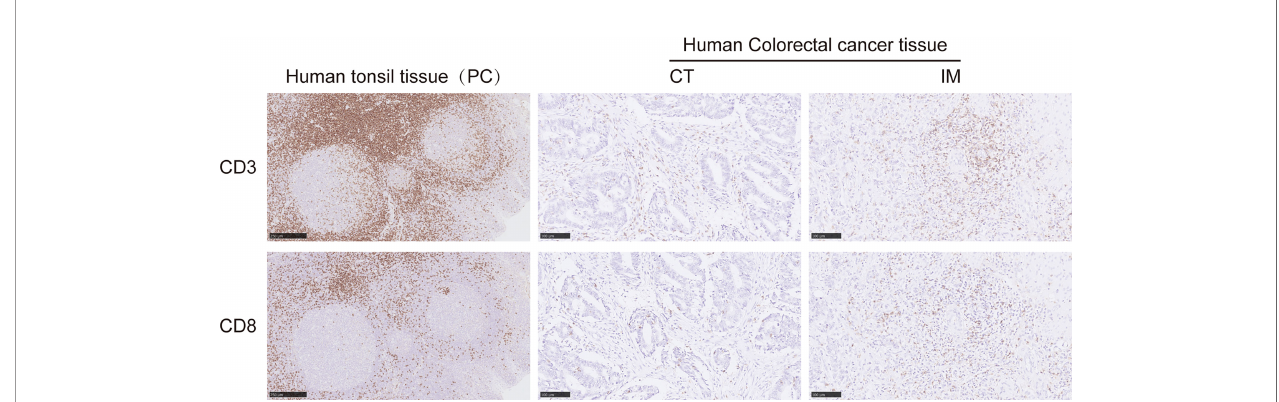
FIGURE 1 | Representative immunohistochemical images of CD3 + and CD8 + T cells on formalin- fi xed paraf fi n-embedded sections from human colorectal cancer (CRC) tissue. Representative images of CD3 + T cells in the CT ( middle upper panel ) and IM ( right upper panel ) and CD8 + T cells in the CT ( middle lower panel ) and IM ( right lower panel ). Human tonsil tissues were stained as positive controls for CD3 and CD8 positive staining ( left upper and lower panels ). CT, the core of the tumor; IM, invasive